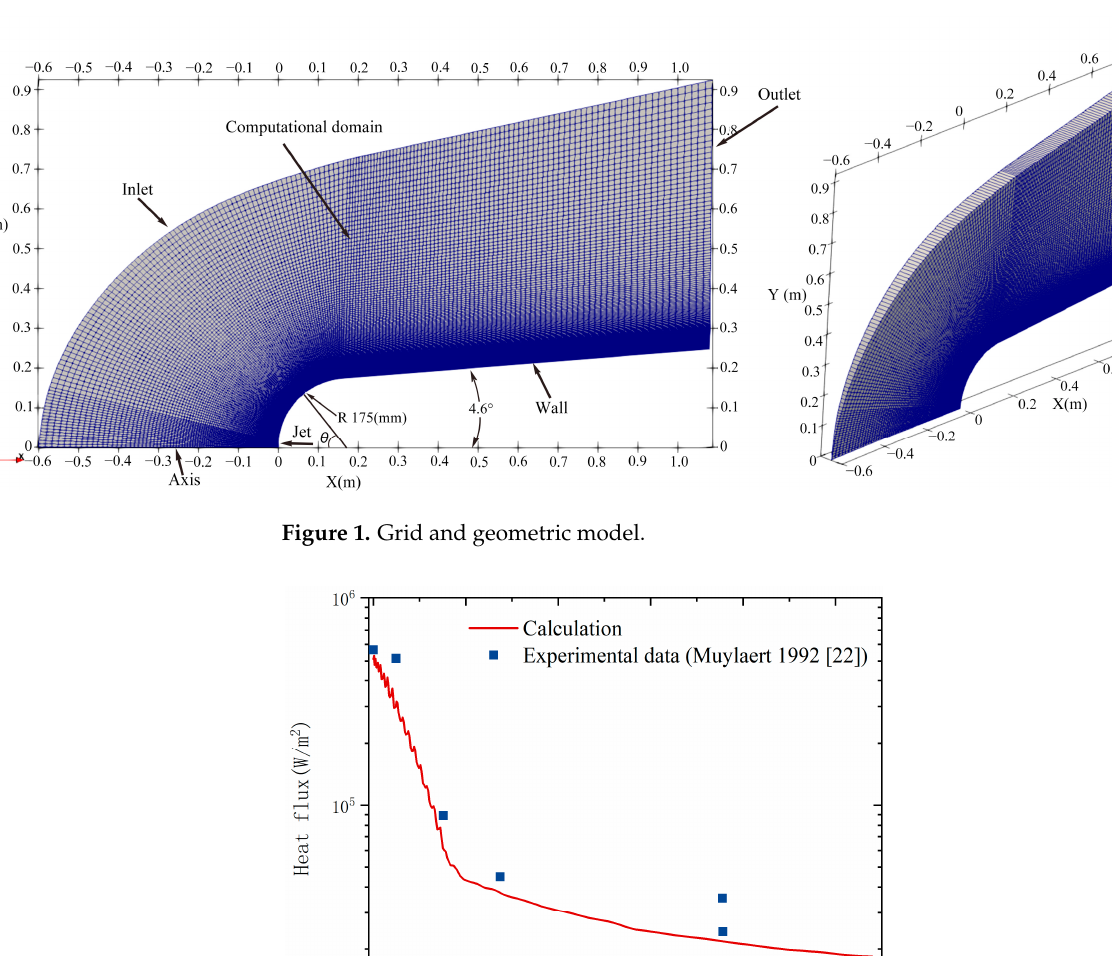
Figure 1. Grid and geometric model.